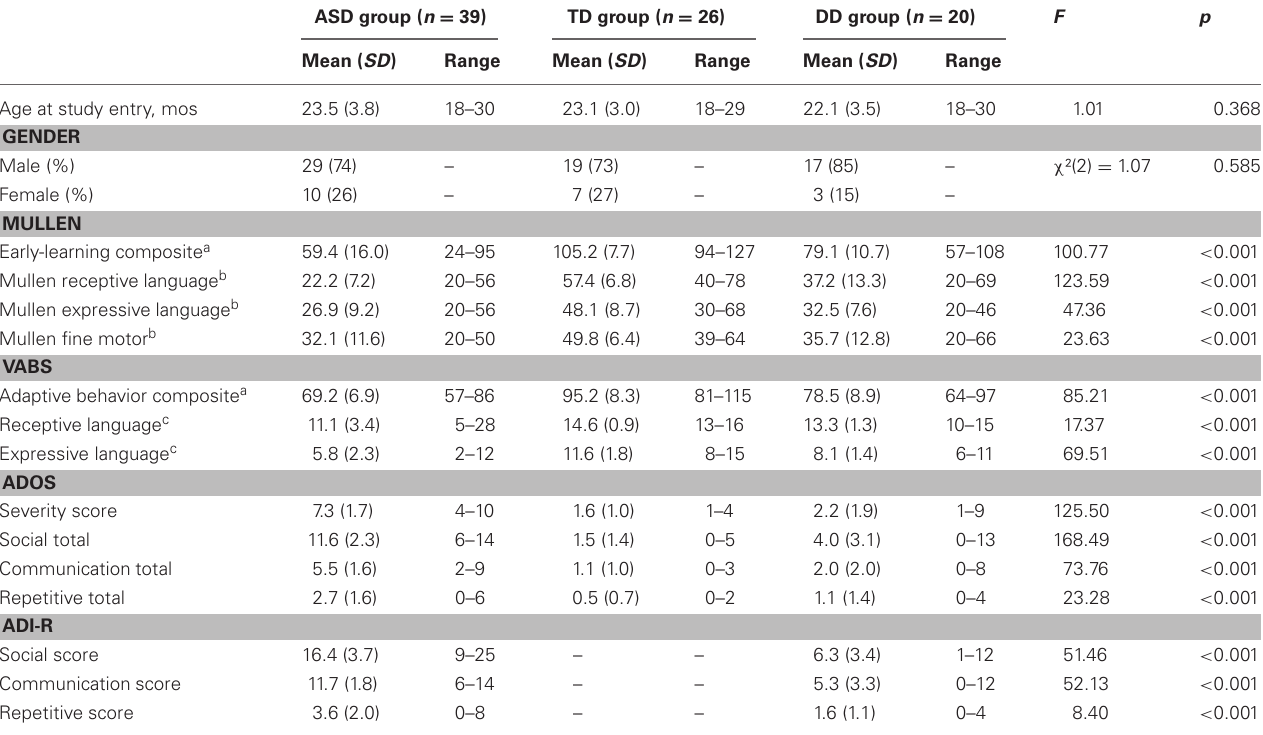
Table 1 | Clinical characteristics and behavioral measures for ASD, TD, and DD